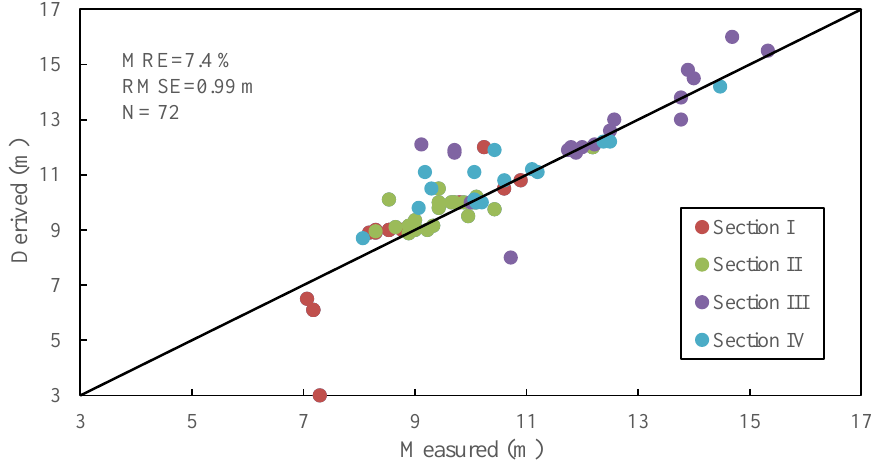
Figure 10. Comparisons between the measured and derived topographic data of Sections I to IV: The black line is the 1:1 line. N is the total number of the measured points.